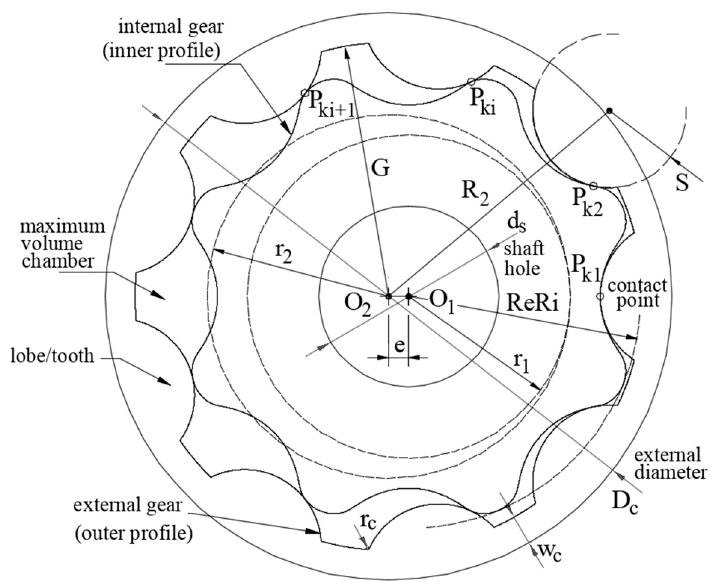
Figure 2. Basic geometric parameters of the trochoidal gear set.